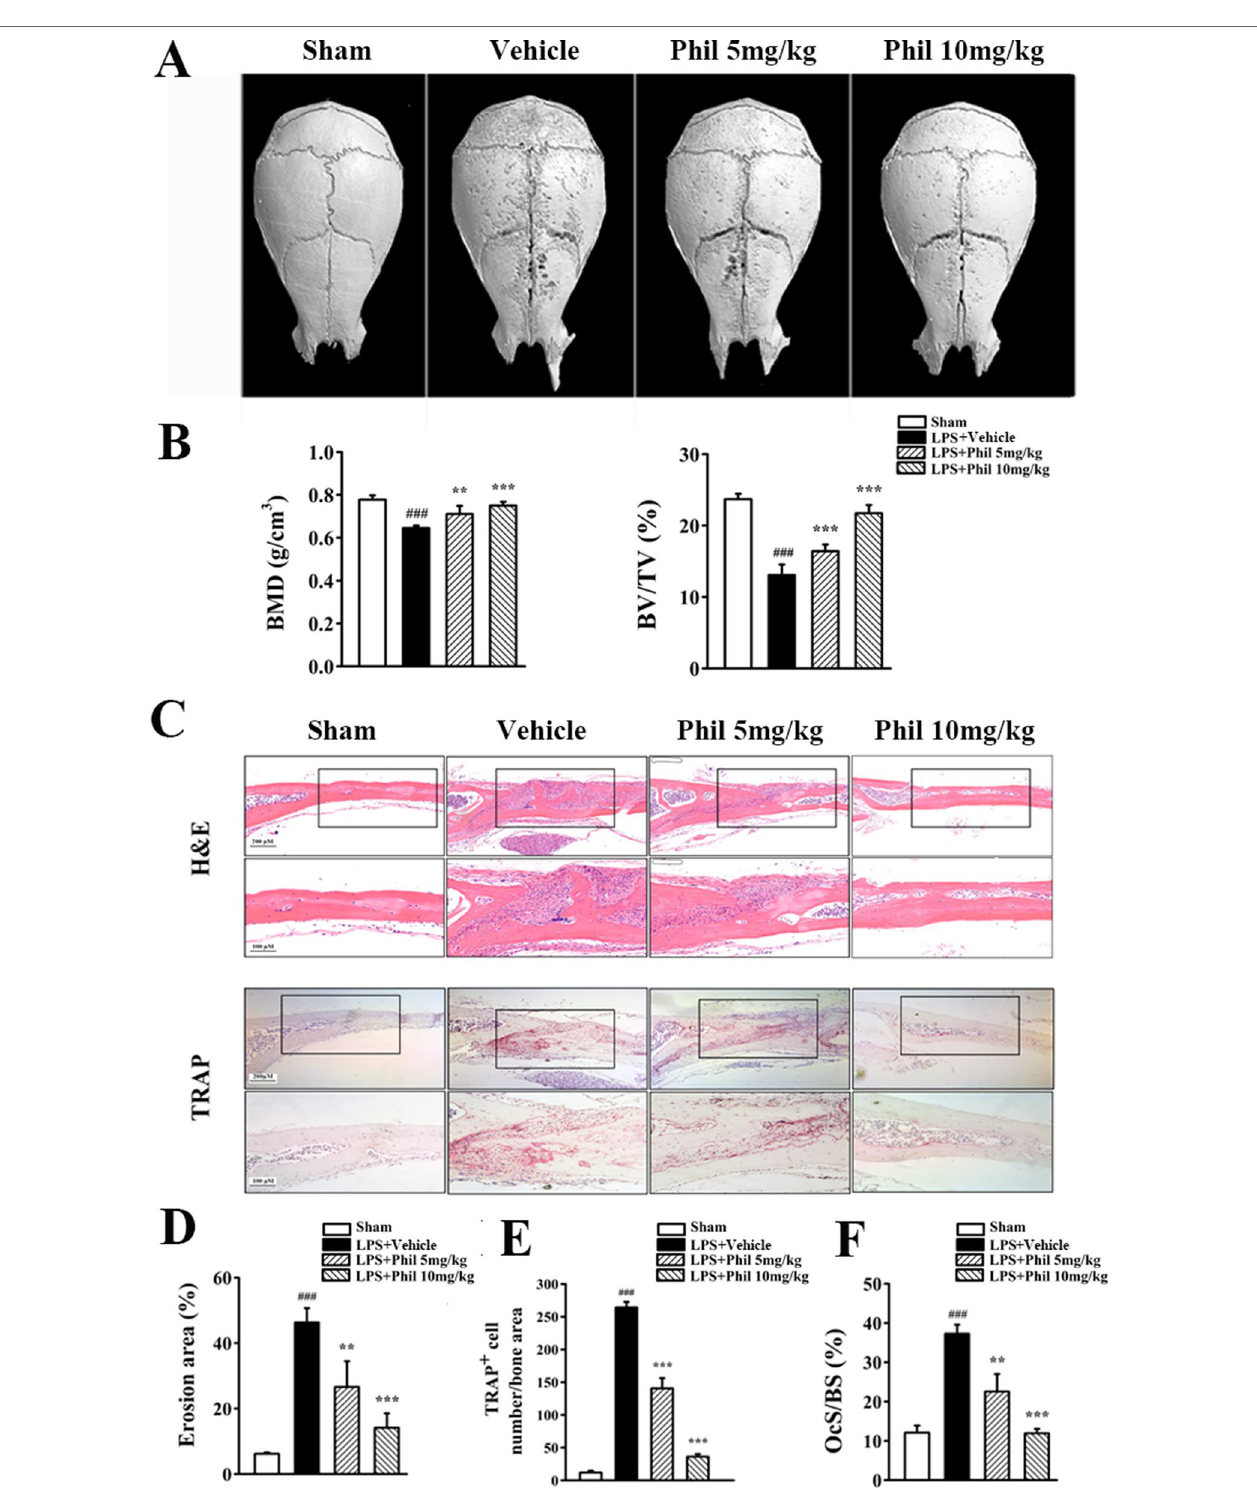
FIGURE 6 | Phil inhibits LPS-induced osteolysis in mice. (A) Representative 3D reconstruction of the whole calvarias from different groups. (B) The quantitative analysis of bone mineral density (BMD) and bone volume/tissue volume (BV/TV) (n = 7). ### P < 0.001 relative to the sham group; ** P < 0.01 and *** P < 0.001 relative to the vehicle group. (C) Representative images of calvarial sections stained with H&E and TRAP from different groups. (D–F) Histomorphometric analysis of the percentage of infiltrated fibrotic area against total tissue area (erosion area, %), the number of TRAP + osteoclasts normalized to bone area, and the percentage of osteoclast surface per bone surface (OcS/BS, %) (n =